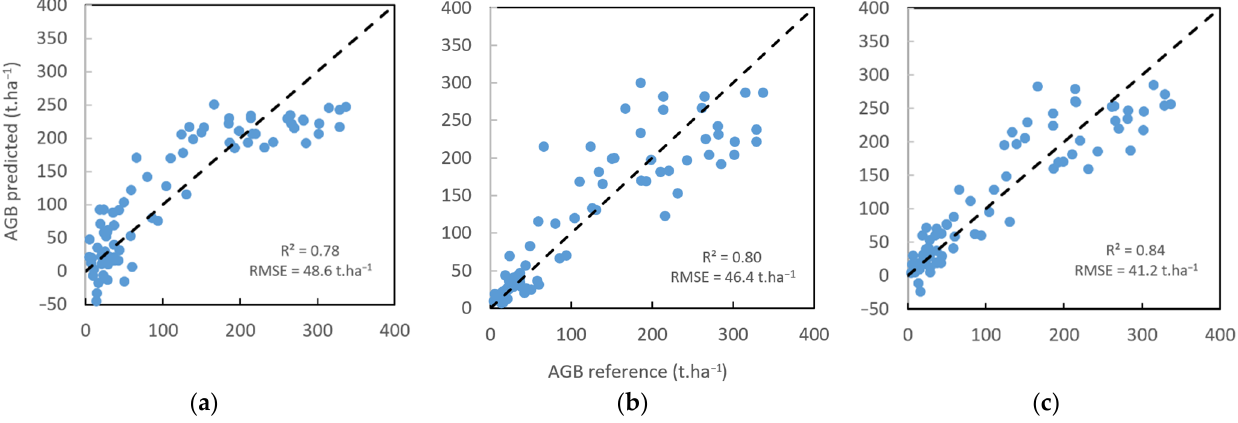
Figure 5. Reference versus predicted AGB for different regression models: ( a ) MR1, ( b ) MPW and ( c ) MR2. Predicted values were calculated using regression coefficients averaged from 500 bootstrap runs.